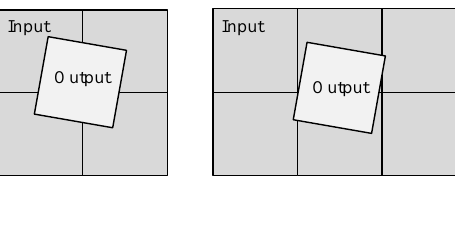
Figure 9. Positional relationship of output and input data.